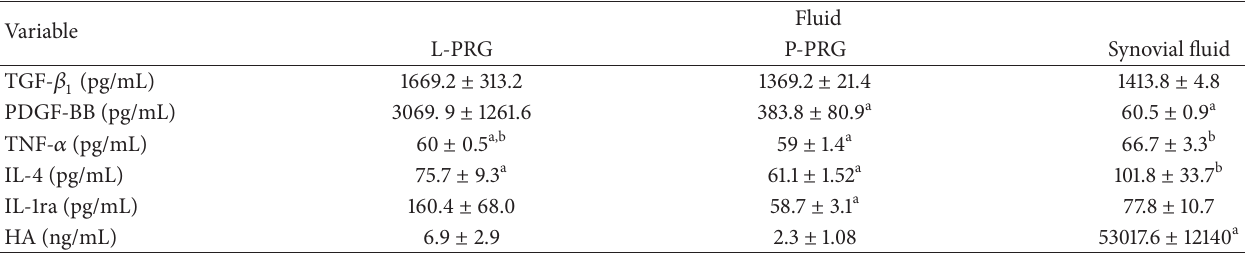
Table 1: Mean (mean standard error) of the concentration of the molecules evaluated in both leukocyte and platelet-rich gel (L-PRG) and pure platelet-rich gel (P-PRG) supernatants and synovial